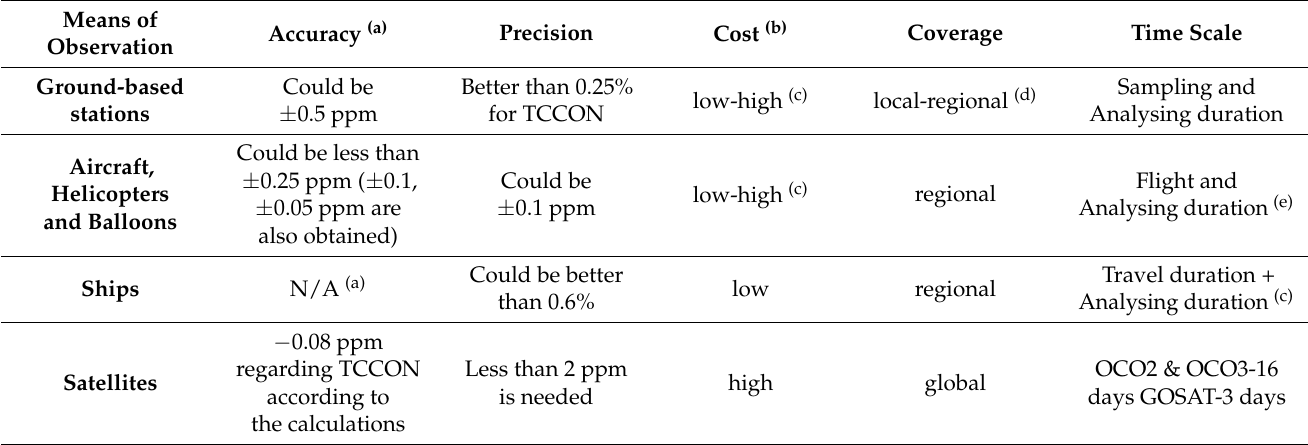
Table 1. KPI table of the means of